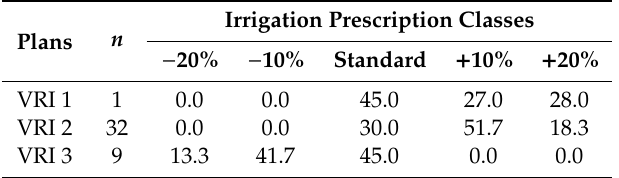
Table 3. Area (percentage of the total) that each prescription class represented in each variable rate irrigation (VRI) plan.